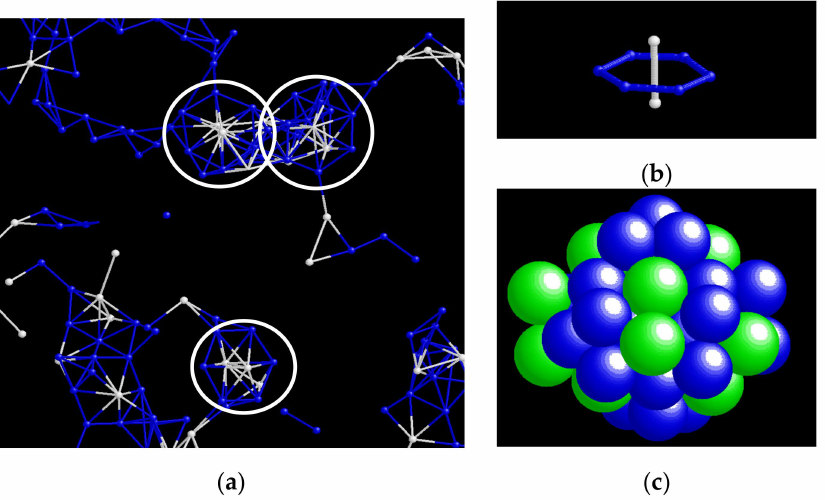
Figure 10. ( a ) A portion of network formed by I- and Z-clusters connecting via bicap-sharing found in a glassy phase of the r BB = 0.8 A 50 B 50 system, where spheres denote the central atoms of I-clusters (blue) and Z-clusters (white) and sticks denote the bicap-sharing bonds between them. Snapshots of atomic configuration of a typical unit found in the same A 50 B 50 glassy phase: ( b ) Six pentagonal bicap sharing bonds (blue) between six I-clusters penetrated by a hexagonal bicap-sharing bond (white) between two Z-clusters. ( c ) All atoms belonging to the unit structure, where green and blue spheres denote the A and B atoms,